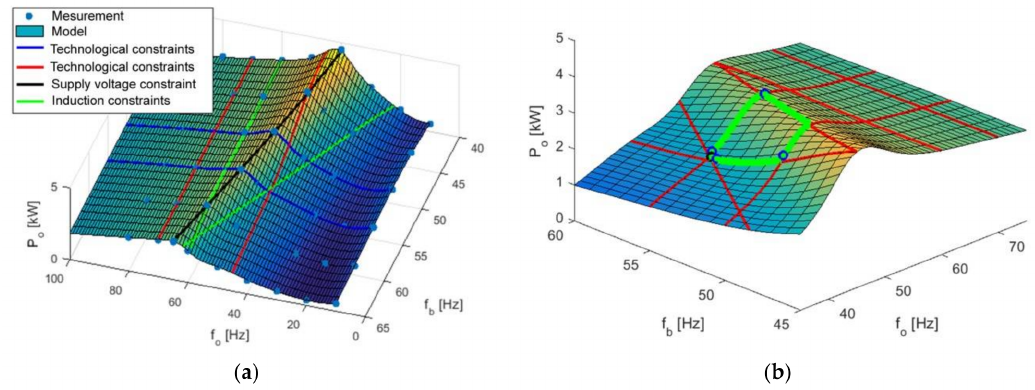
Figure 18. ( a ) All of the constraints in optimization task; and, ( b ) feasible